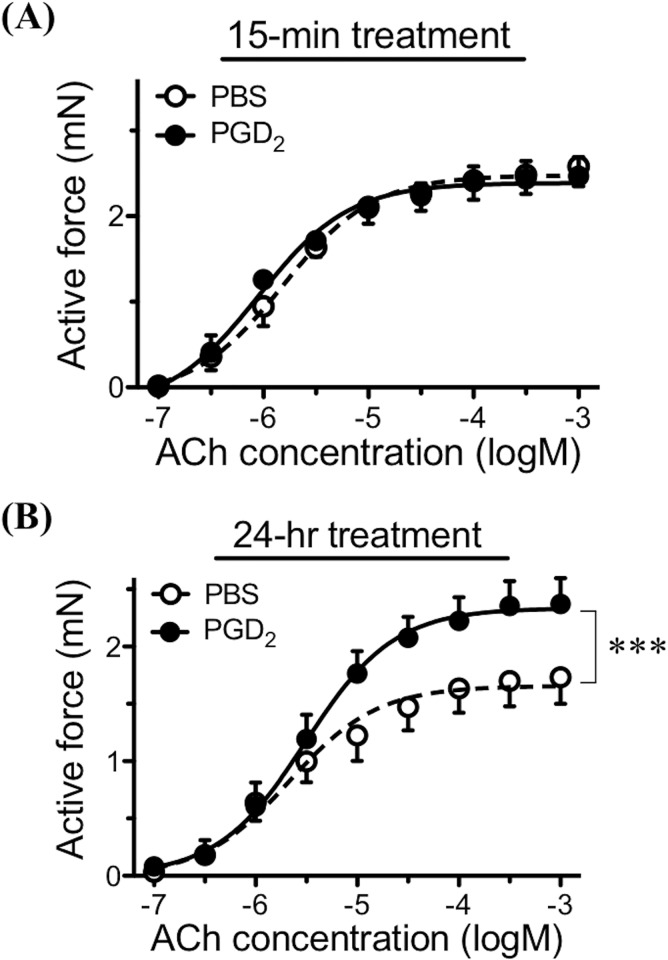
Effect of prostaglandin D2 (PGD2) on bronchial smooth muscle (BSM) contractility in naive mice. The BSM tissues isolated from naive BALB/c mice (6 animals) were incubated with PGD2 (10−5 M: closed circles) or its vehicle (PBS: open circles) for 15 minutes (A) or 24 hours (B). The BSM responsiveness to cumulatively applied acetylcholine (ACh) was measured as described in METHODS. The ACh concentration-response curve was significantly shifted upward when the BSMs were incubated with PGD2 for 24 hours (B: ***P < 0.001 by one-way ANOVA with post hoc Dunnett).